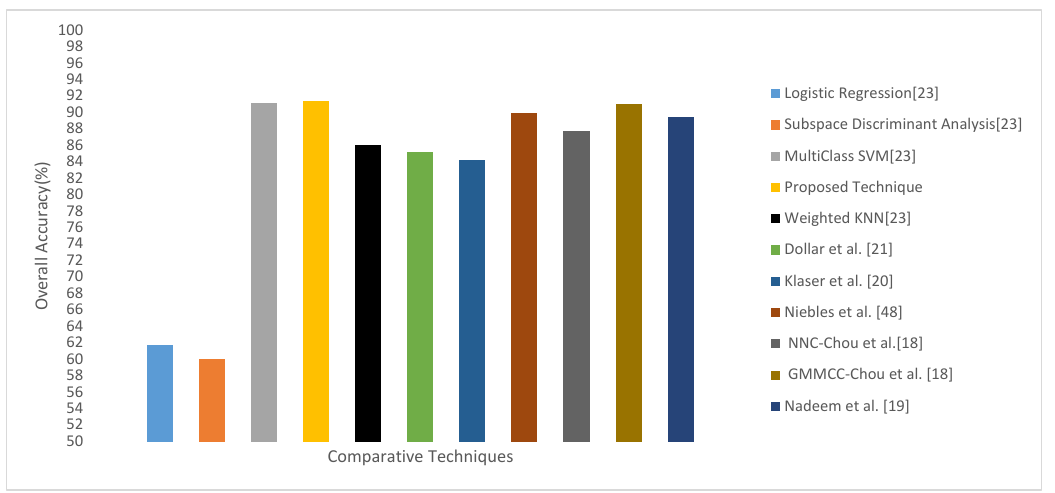
Figure 13. Accuracy based comparative results of the proposed technique with existing